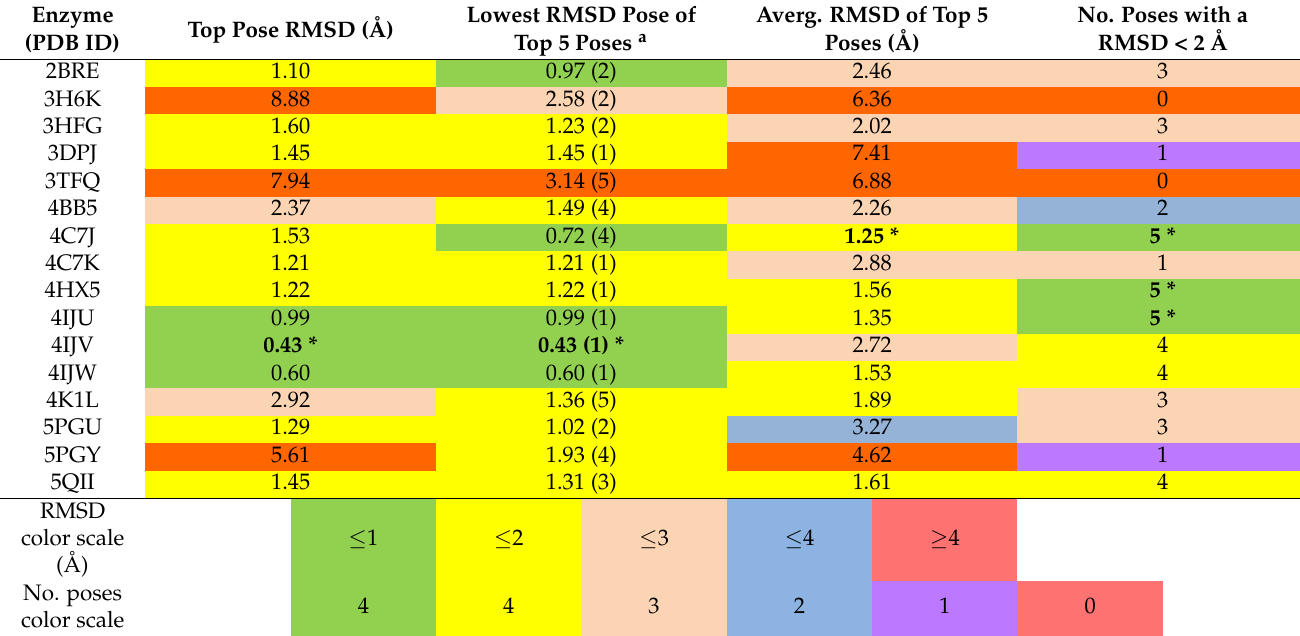
Table 6. Self -docking results of the sixteen holo 11 β -HSD1 X-ray structure using the docking evaluation